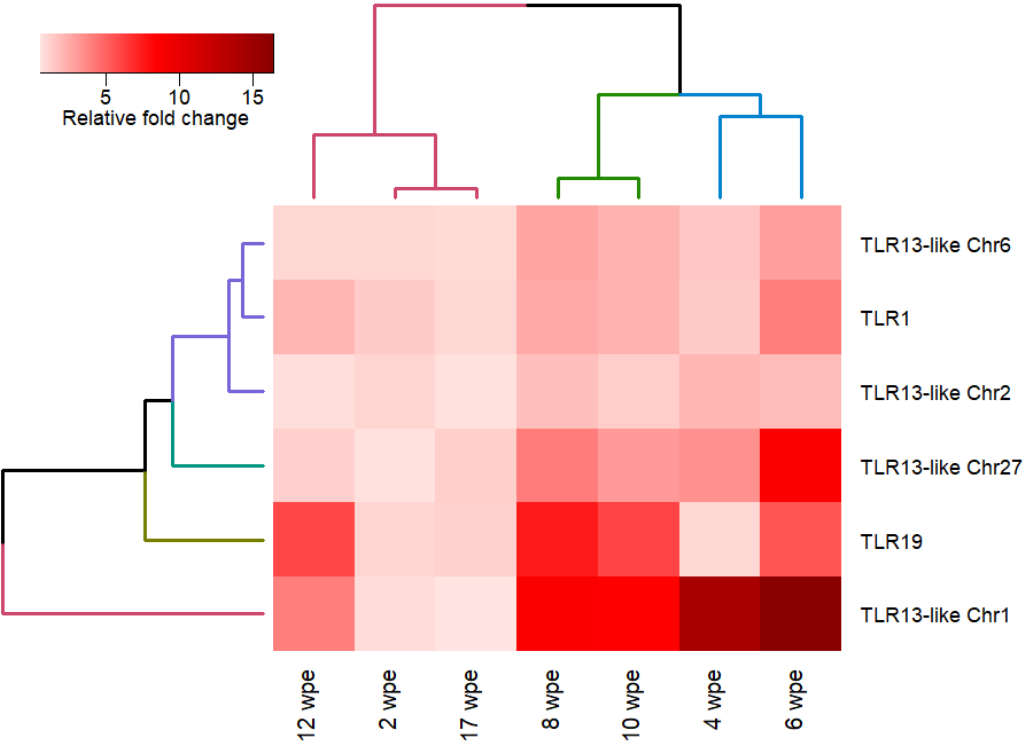
Figure 8. Heatmap representation of quantitative real time (qRT-PCR) expression profile of TLRs in the posterior kidney of brown trout at various time points. The expression levels of genes are presented using relative fold change values of exposed compared to control groups. Euclidean distance and complete linkage method was used for hierarchical